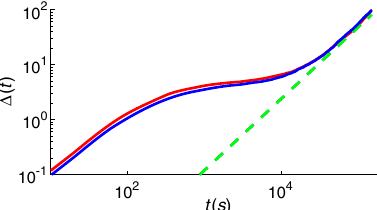
FIG. 18. Mean-square displacement Δ ð t Þ with (blue) and without (red) random noise. The slopes obtained from the long time limit are both 1.3 (dashed green). The two curves are almost identical, thus justifying the neglect of the random noise [second term in Eq. (A1)] in the simulations.